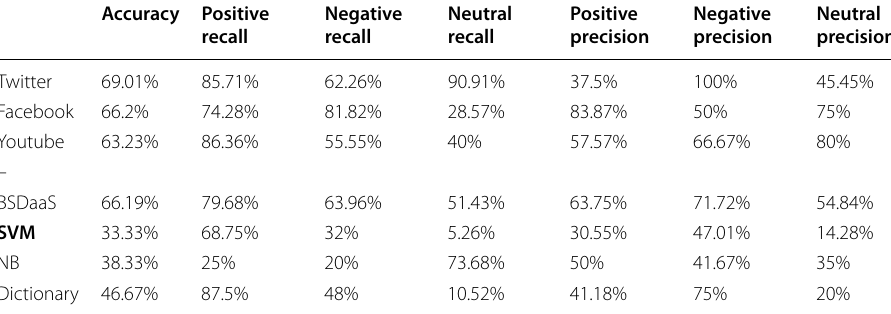
Table 3 Evaluation of data analysis